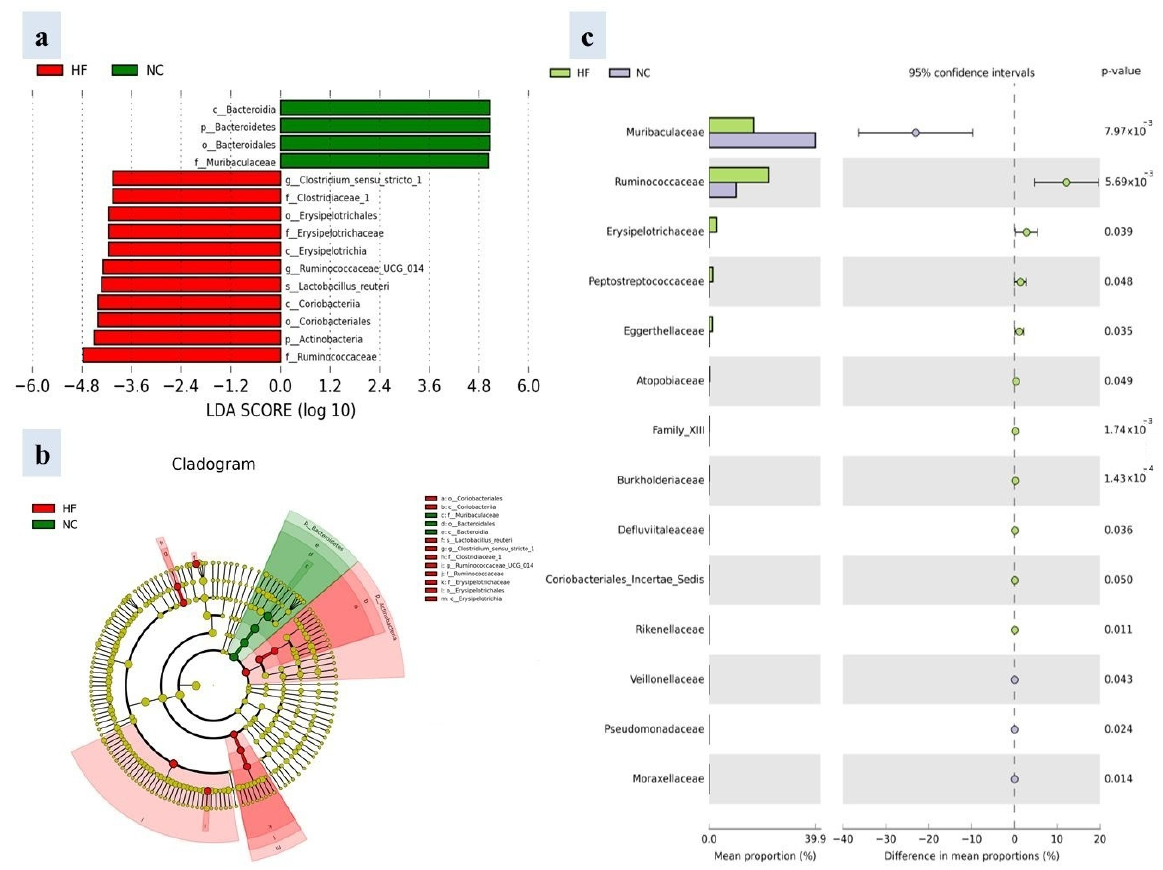
Figure 4. ( a ) Linear discriminant analysis effect size analysis (LEfSe) with linear discriminant analysis (LDA) score > 4 between normal control (NC) and high-fat control (HF) groups. ( b ) Cladogram of gut microbiota between NC and HF groups. ( c ) STAMP analysis of bacterial taxon shown at family level between NC and HF groups. The value of p < 0.05 was considered significant ( n = 5 per group).